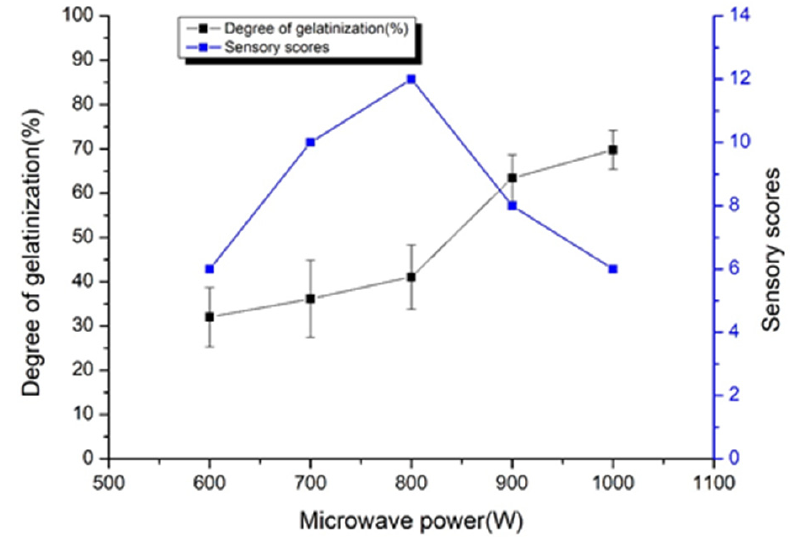
Figure 2. Changes in the degree of gelatinization and sensory scores of adzuki beans pre-cooked of different microwave power.